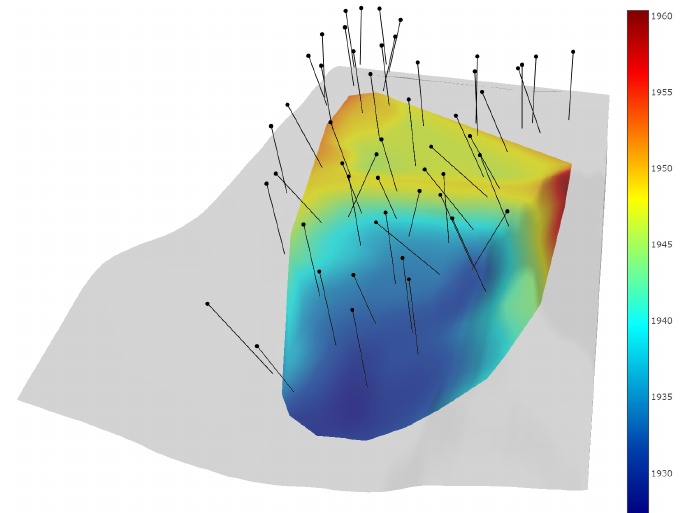
Figure 7. Initially optimized camera location and orientations are based on publicly available elevation data. The initial optimized flight ensures safety to people and equipment while recreating a quicker fuller model than a grid flight. Elevation units are m.